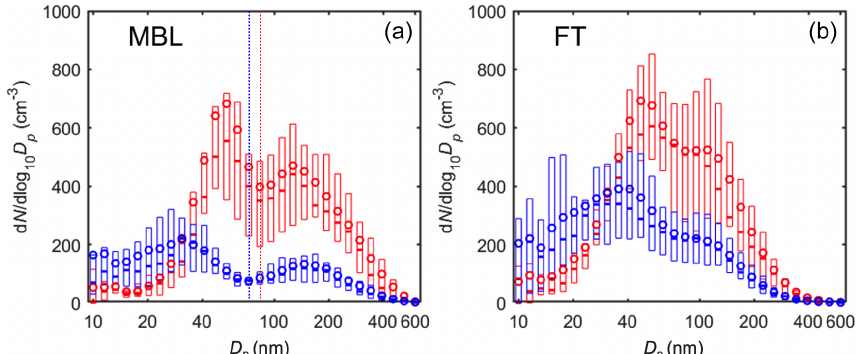
Figure 5. Aerosol size distributions measured by the FIMS on board the G-1 aircraft within (a) the MBL and (b) lower FT during the summer IOP (red) and winter IOP (blue). The line and circle markers represent the median and mean of the size distribution, and the edges of the box indicate the 25th and 75th percentiles, respectively. The dotted lines in panel (a) show the Hoppel minimum for the averaged size distributions in the